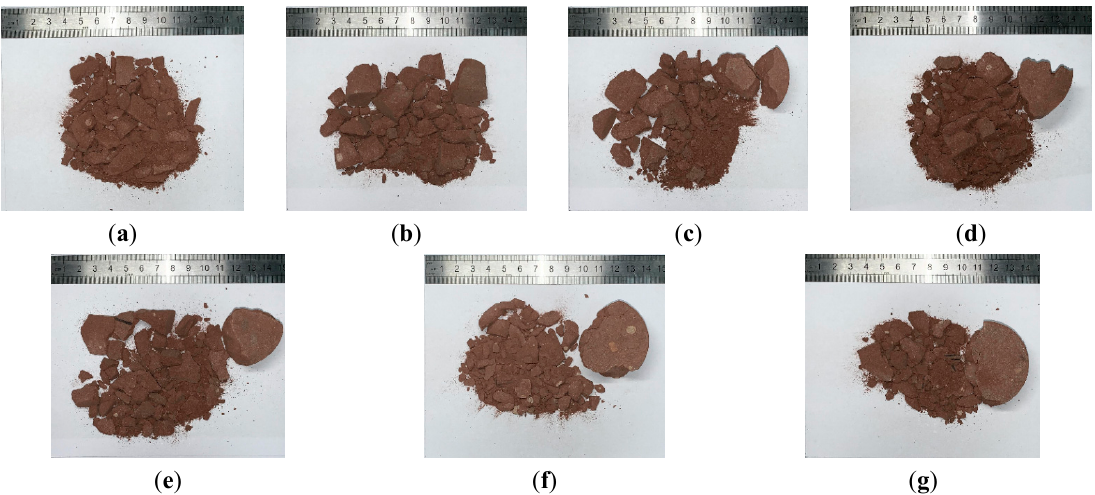
Figure 16. The breakage conditions of the rock specimens under a 0.30 MPa impact pressure in the SHPB test: ( a ) R1-7-1, ( b ) R6-1-1-1, ( c ) R6-2-1-1, ( d ) R7-1-1-1, ( e ) R7-2-1-1, ( f ) R8-1-1-1 and ( g ) R8-2-1-1.